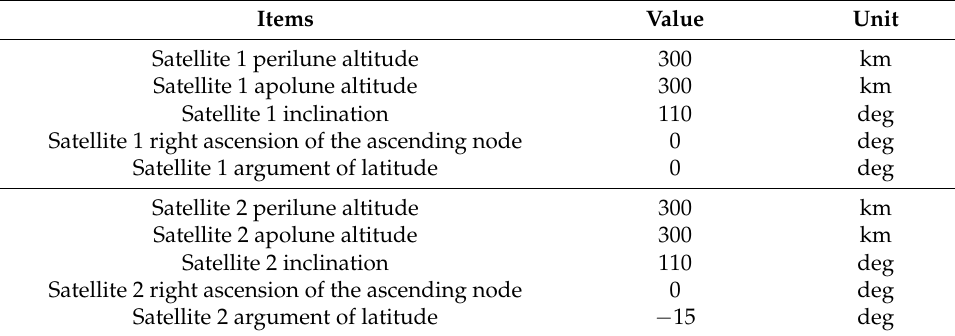
Table 11. The satellite orbital parameters used in the